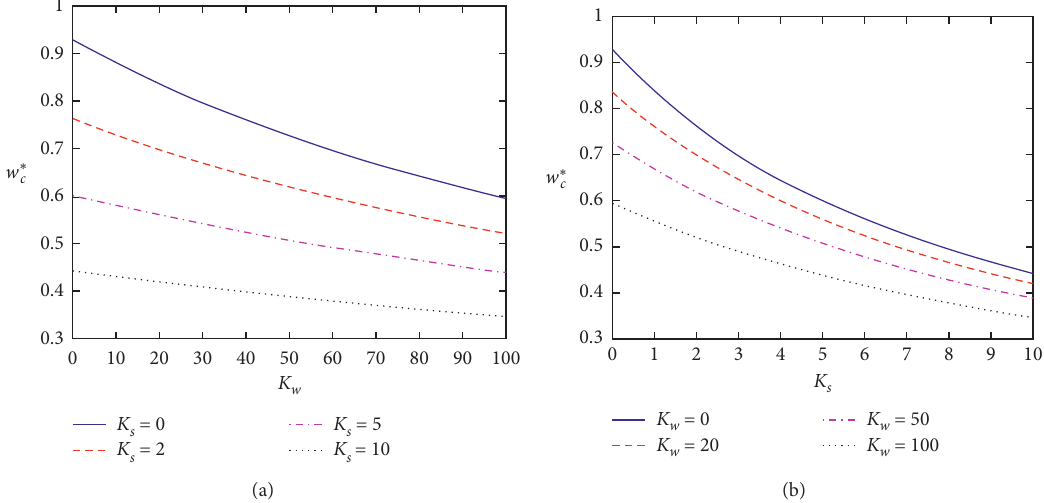
Figure 8: The influence of two parameters of the elastic foundations on the deflection of the plates with a/h � 10, p �